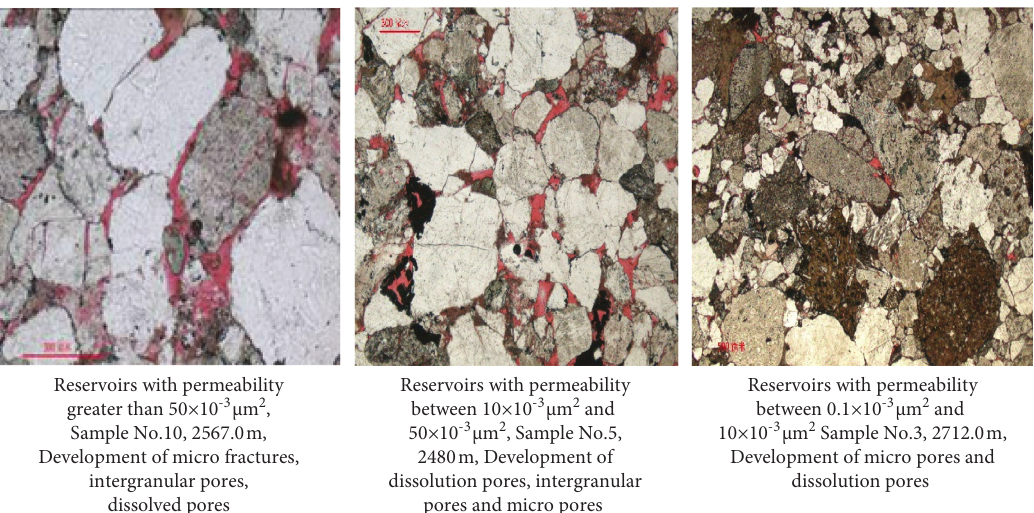
Figure 1: Reservoir spatial characteristics of reservoirs with different